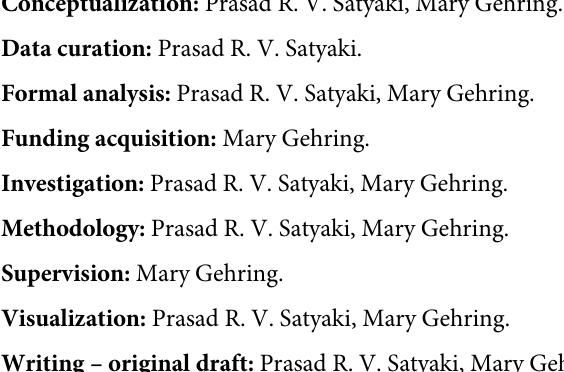
S4 Data. Data underlying Fig 3. Analysis of gene expression changes in nrpd1− / − , mat nrpd1 +/− , and pat nrpd1+/− . S5 Data. Data underlying S6 Fig. Analysis of imprinted gene expression in nrpd1− / − , mat